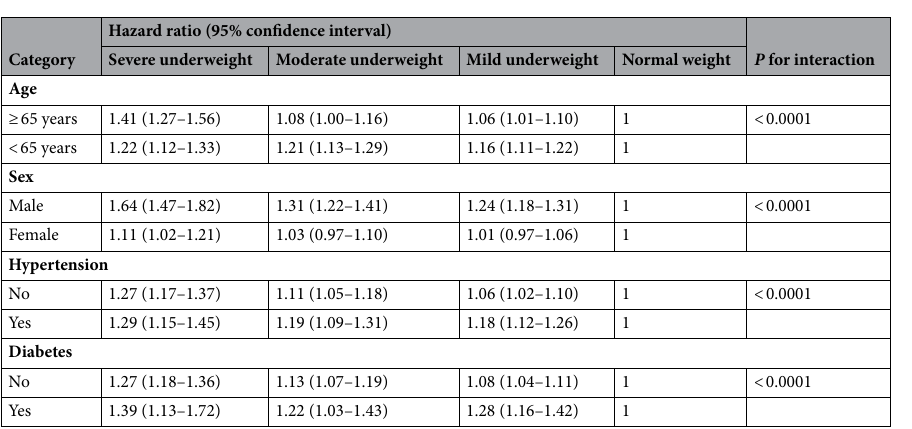
Table 3. Fracture risk subgroup analyses according to the degree of underweight. Adjusted for age, sex, smoking status, drinking status, low income, regular exercise, diabetes, hypertension, dyslipidemia, and chronic kidney disease. There were no significant differences in other subgroup analyses, which included associations of fracture risk with smoking, drinking, regular exercise, low income, dyslipidemia, and chronic kidney